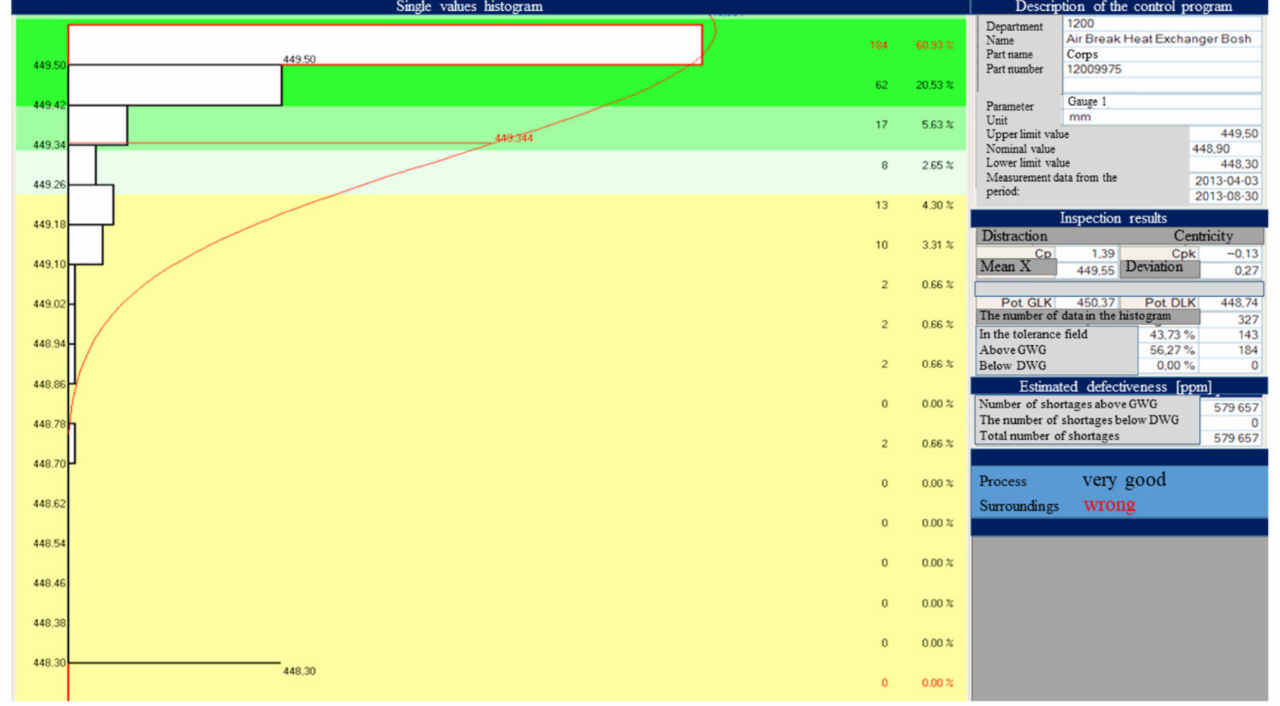
Figure 26. Histogram showing an anomaly in the process.